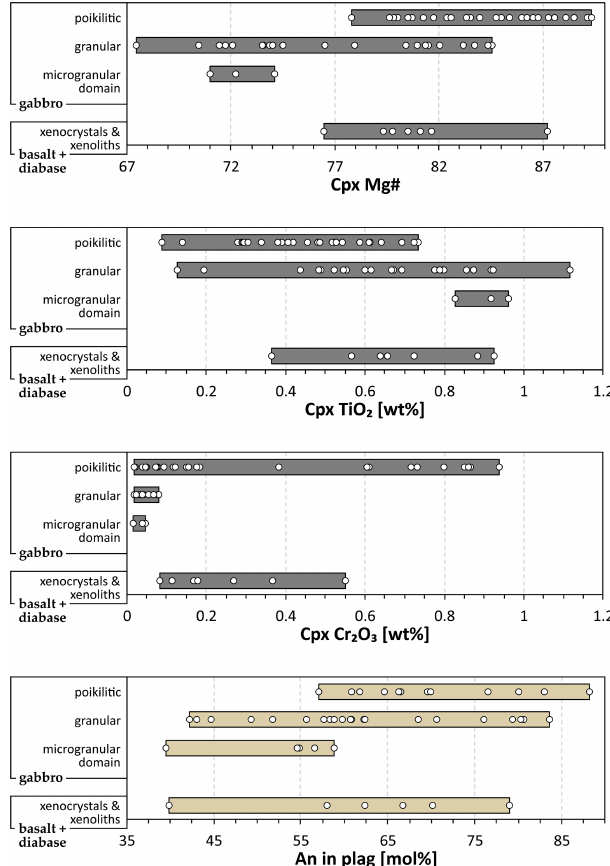
Figure 8. Range of compositions (bars) and averages (white cir- cles) of clinopyroxene and plagioclase recorded in different tex- tural domains. Compositional variation in Mg#, TiO 2 and Cr 2 O 3 in clinopyroxene, showing higher values in the poikilitic domains except for TiO 2 , which is consistent with the more primitive na- ture of the poikilitic domains. Clinopyroxenes from microgranular domains show significantly lower Mg#’s. Since the compositional zoning is significantly narrower in clinopyroxenes compared to pla- gioclase, bars include core measurements. The compositional vari- ation in An contents from core measurements shows higher values in the poikilitic domains overlapping with the granular